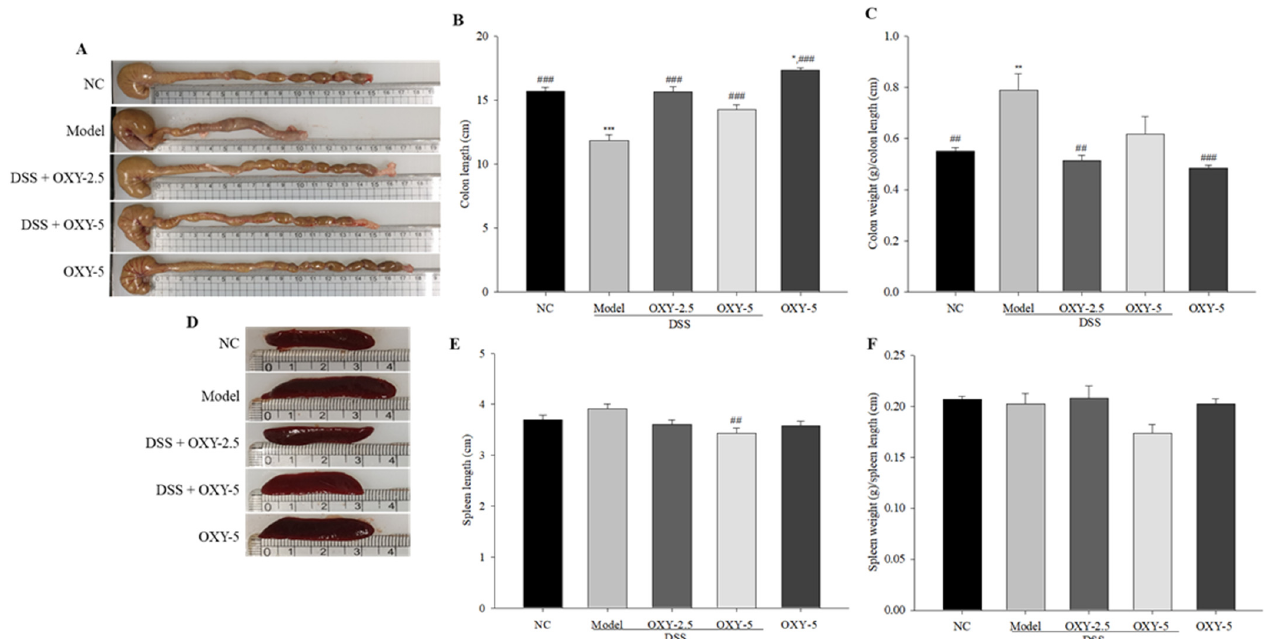
Figure 2. Effect of OXY on the length and weight of the colon and spleen ( n = 8/group). Colon length was measured ( A , B ), after which colon weight was determined and normalized to colon length ( C ). Spleen length was measured ( D , E ), after which spleen weight was determined and normalized to spleen length ( F ). NC, normal control group; model, DSS-induced colitis model group; DSS + OXY-2.5, DSS-induced colitis rats treated with OXY (2.5 mg/kg) group; DSS + OXY-5, DSS- induced colitis rats treated with OXY (5 mg/kg) group; OXY-5, rats treated with OXY (5 mg/kg) alone group. The values are expressed as mean ± SEM. Significant differences among groups were evaluated via ANOVA with Tukey’s post hoc HSD. * p < 0.05, ** p < 0.01 and *** p < 0.001 compared with the NC group; ## p < 0.01 and ### p < 0.001 compared with the model group.